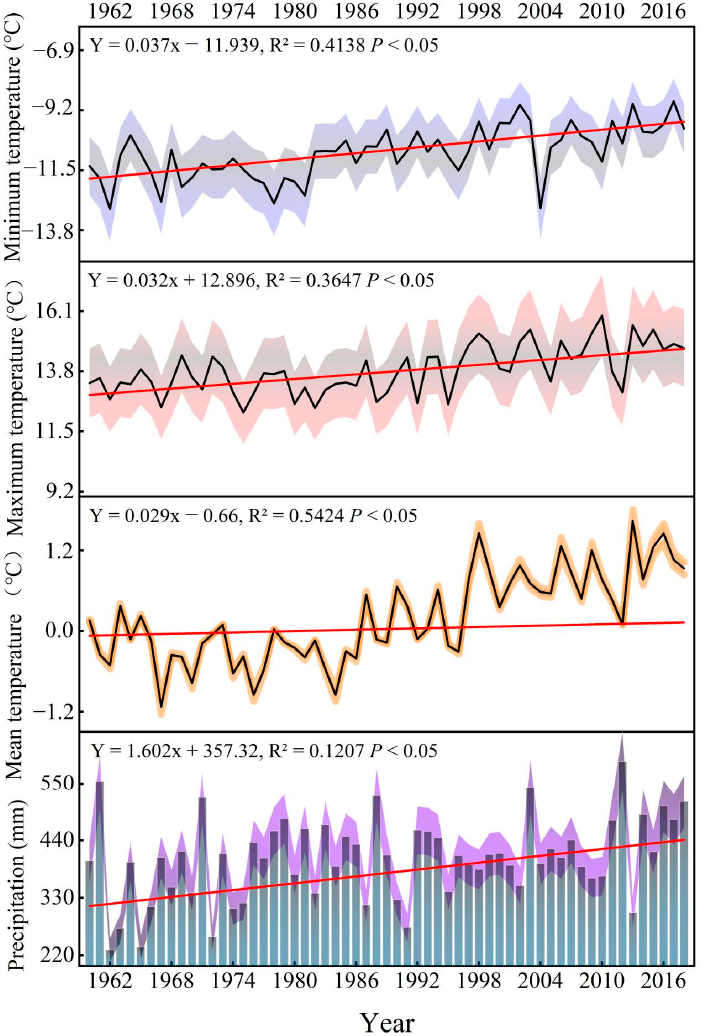
Figure 3. Interannual variations of temperature and precipitation in the study area from 1960 to 2018 (blue, red, and orange, and purple, respectively, indicate the inter-annual variation error range of temperature and precipitation).